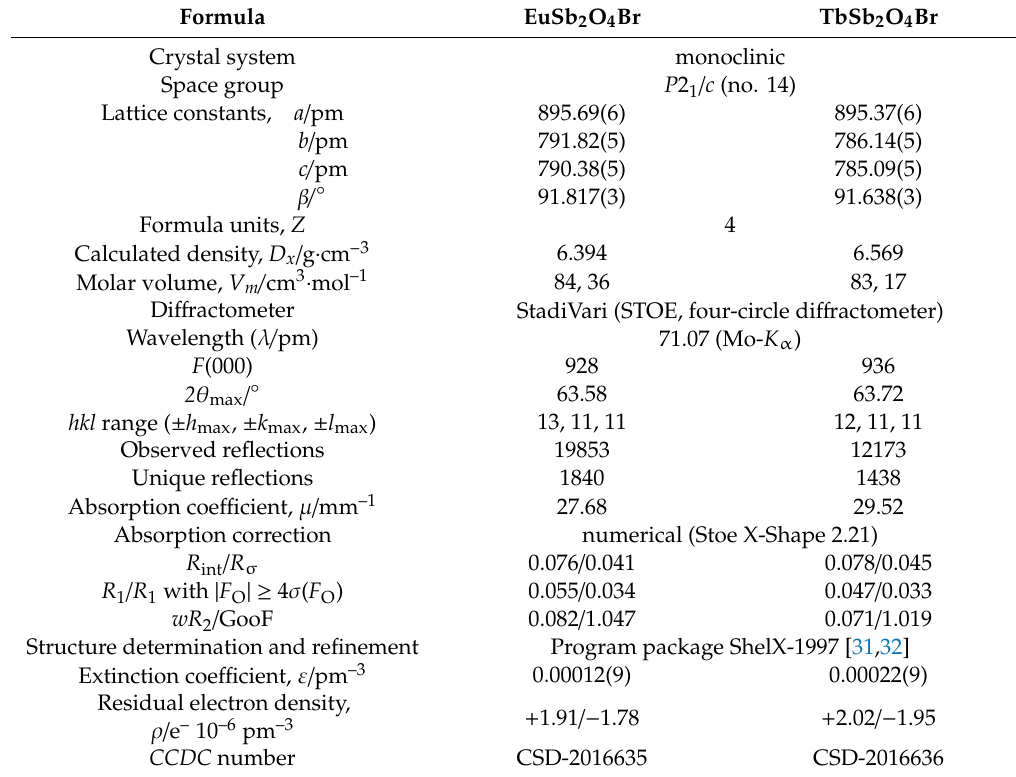
Table A1. Crystallographic data of the end-members of the Ln Sb 2 O 4 Br series ( Ln = Eu and